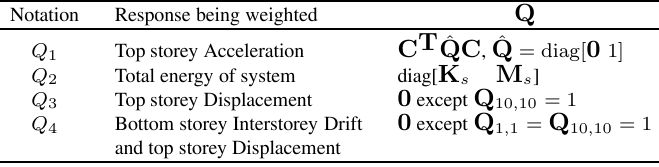
Table 4 Response quantities weighted in PI and corresponding state weighting matrix Q